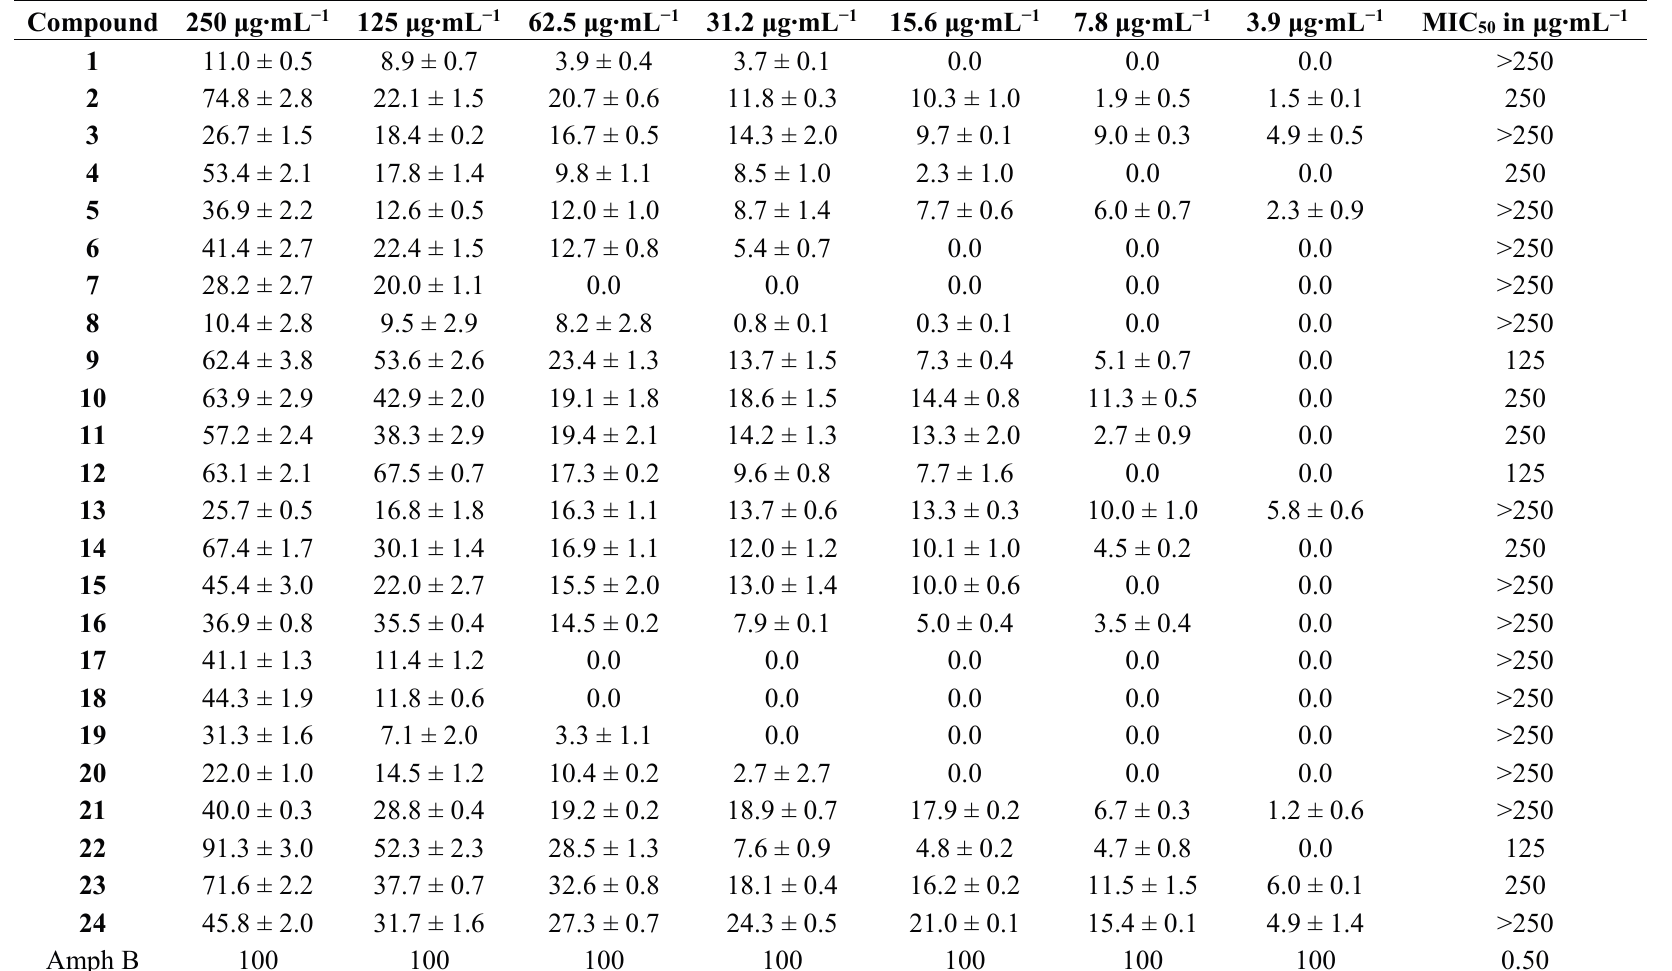
Table 3. Inhibition percentages displayed by 1 – 24 against C. neoformans ATCC 32264 at the concentrations range 250–3.9 μ g·mL − 1 . The minimum concentrations of all compounds necessary to inhibit 50% of fungal growth (MIC 50 ) were included in the table. Standard drug: amphotericin B (Amph